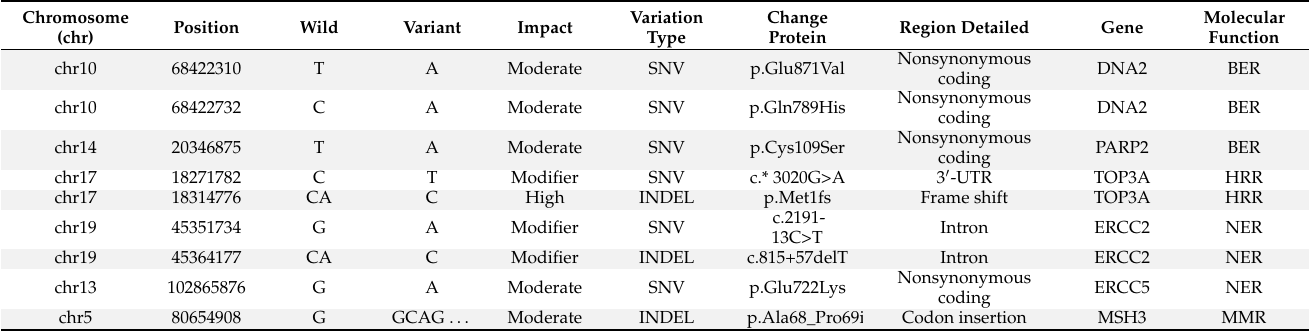
Table 3. New variants found in Native American population from Brazilian Amazon.